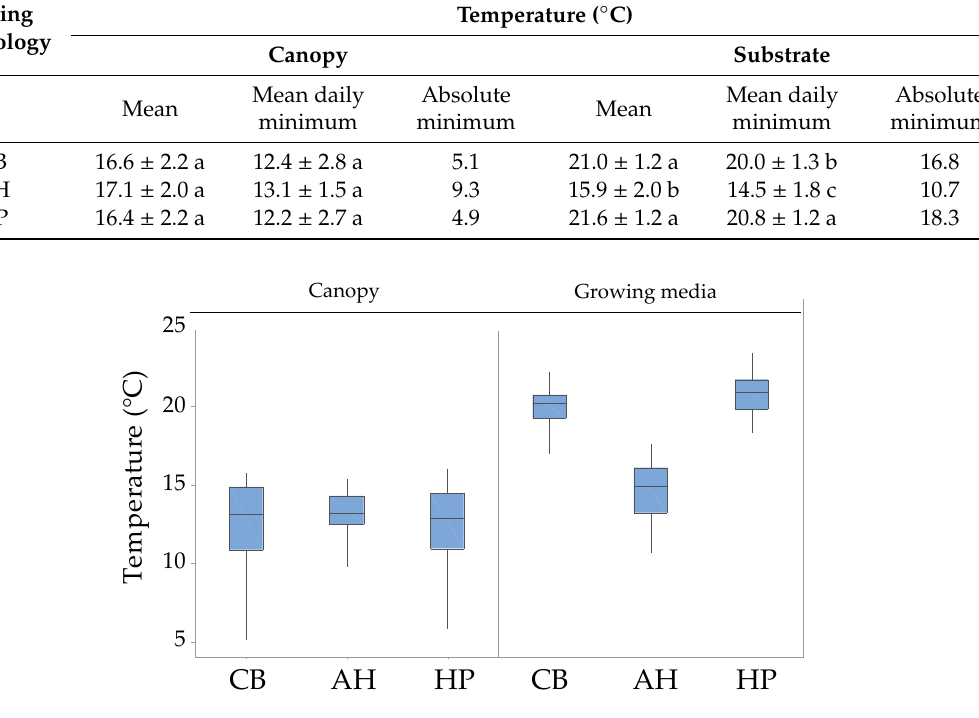
Figure 9. Boxplots of the daily minimum temperatures measured inside canopy and inside the growing media for the different heating systems. CB: condensing boiler; AH: air heater; HP: heat pump. Relative humidity mean values registered inside and outside the greenhouse during the trial are shown in Table 6. Table 6. Mean values of humidity inside and outside the greenhouse during the experimental test. BS: basal heating system; AS: air heating system.